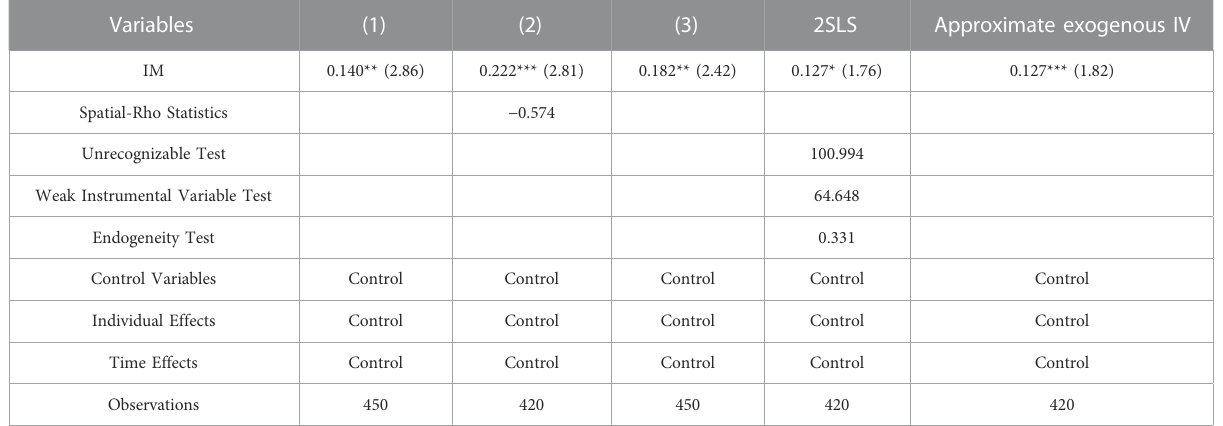
TABLE 3 Robustness test